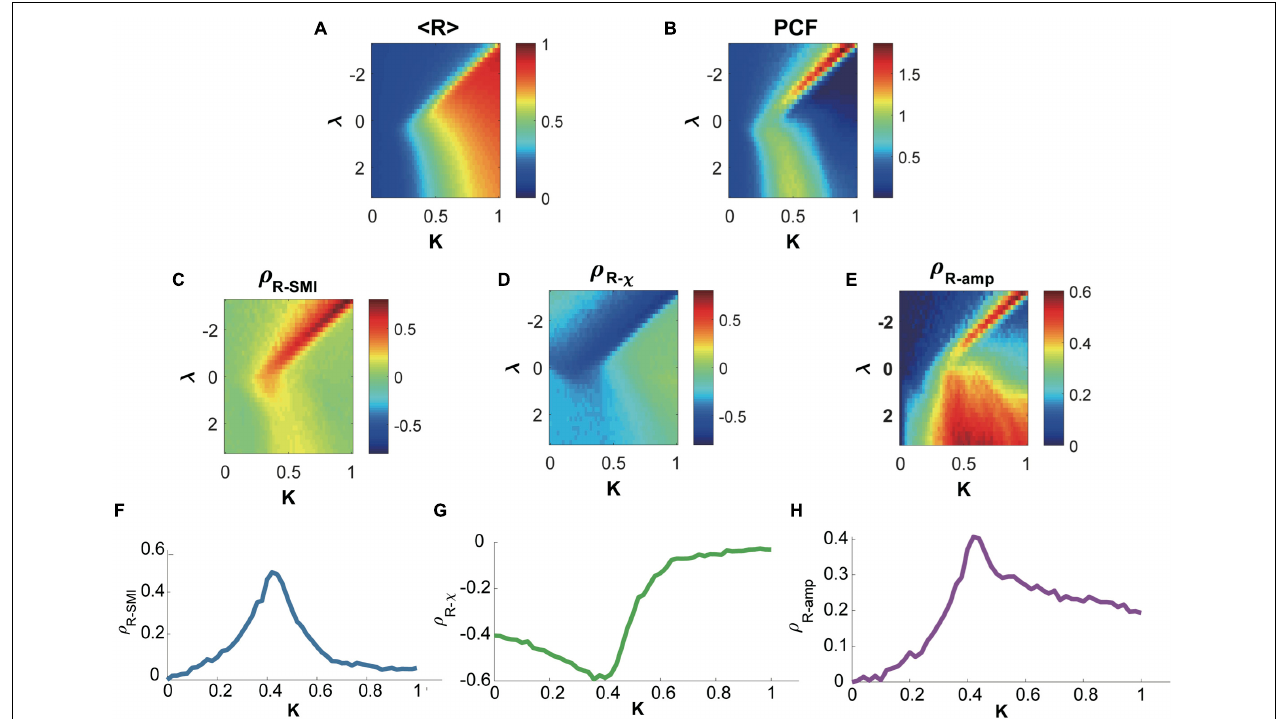
FIGURE 2 | Relationships between network synchronization, symbolic mutual information, network susceptibility, and topographic similarity in the brain network model near and far from criticality. (A) The average network synchronization < R > across all parameter sets K and λ . (B) Pair correlation function (PCF), a surrogate indicator of criticality in parameter space K and λ Accordingly, a critical state is defined with the maximum PCF. Spearman correlations between network synchronization R and (C) symbolic mutual information SMI, (D) network susceptibility χ , and (E) topographic similarity S amp . The brain network model shows a maximum positive (negative) correlation between R and SMI (R and χ ) near the critical states (states with maximum PCF along with K for each λ ). The S amp also shows a maximum positive correlation with R near the critical states. A representative example for the correlation between (F) R and SMI, (G) R and χ , and (H) R and S amp relationship was investigated at λ = − 0 . 6. The critical state appears K ∼= 0 .